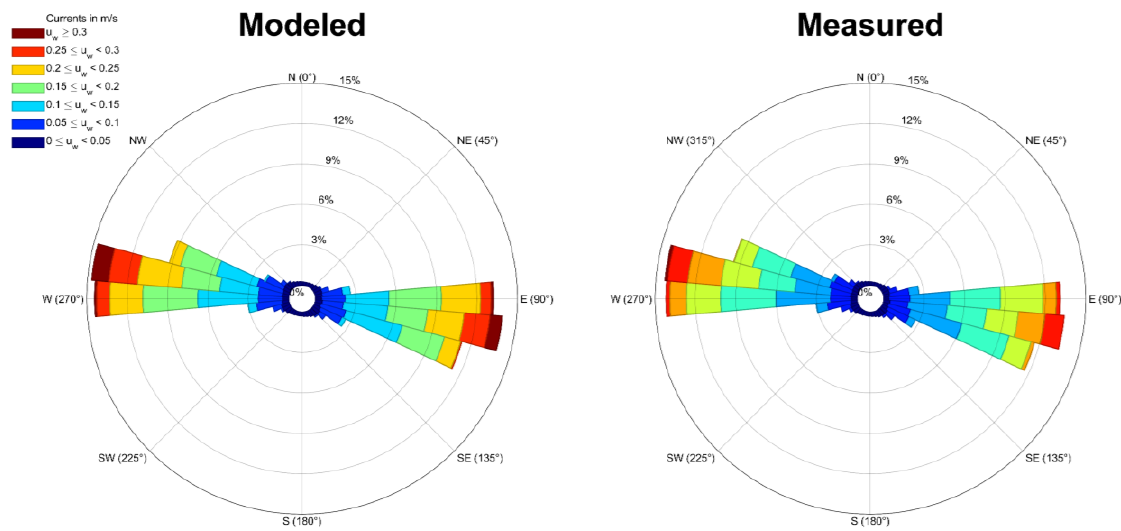
Figure 9. Comparison of the current roses for simulations and measurements for the validation pe- riod.